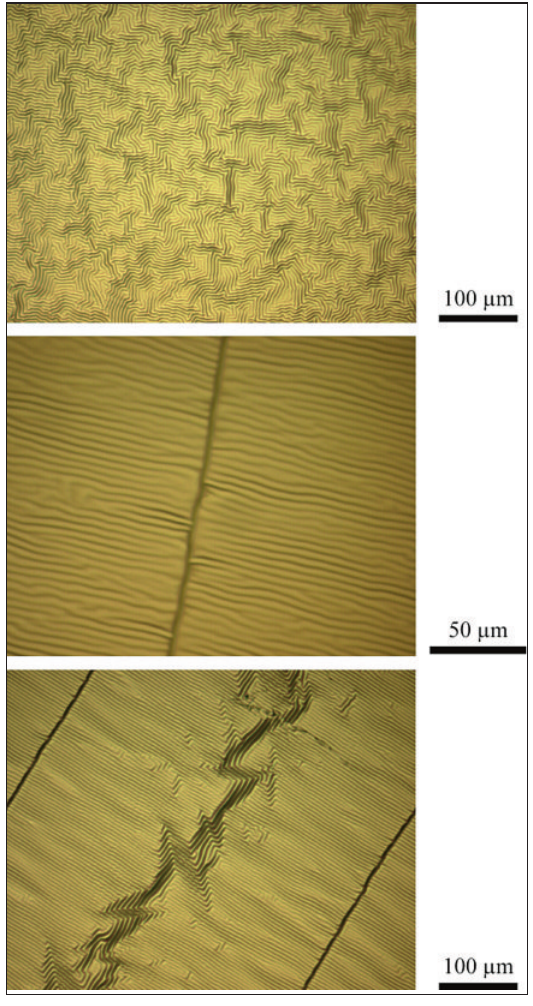
The evaporation of metals such as tita- nium onto silicone often results in the formation of well-de- fined ripple struc- tures that prevent the generation of a homo- geneous electrical field along the micro- or nanostructures. The periodicity of the ripples originates from the different thermal expansion coefficients of elas- tomer and metallic contact layer materi-